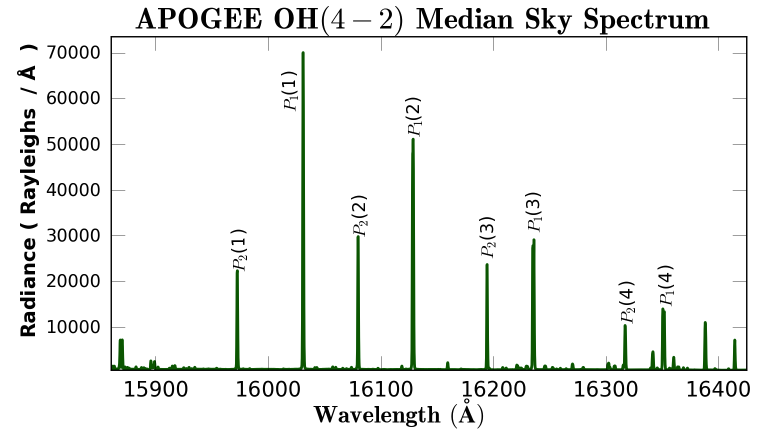
Figure 1. Median APOGEE sky spectrum of the OH ( 4 − 2 ) transition with electronic sub-states and quantum numbers N (cid:48) labeled for each emission